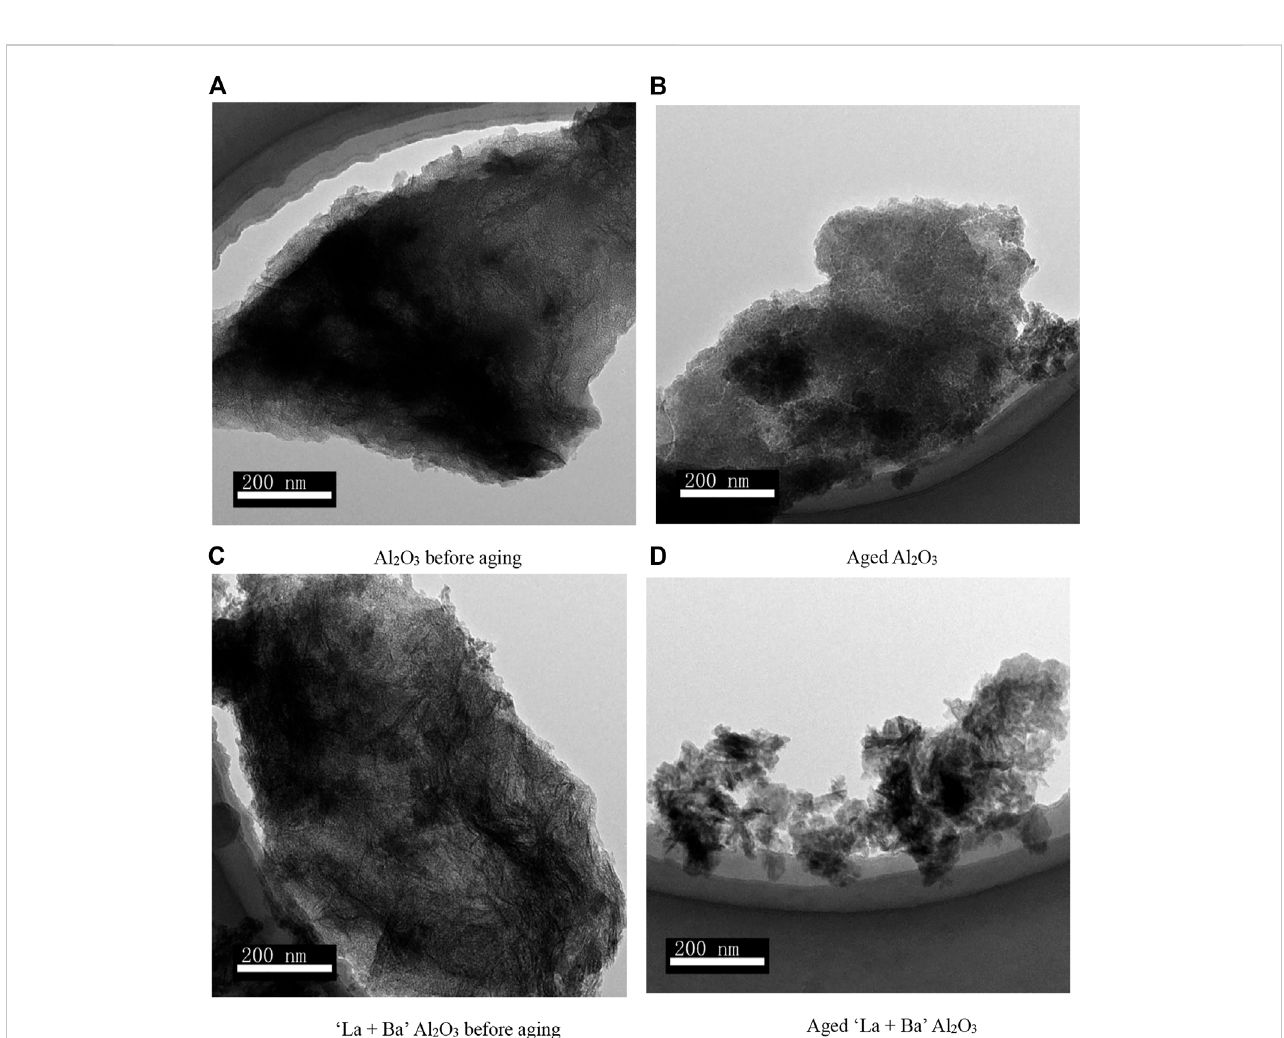
FIGURE 9 TEM images before and after aging at 1,100 °